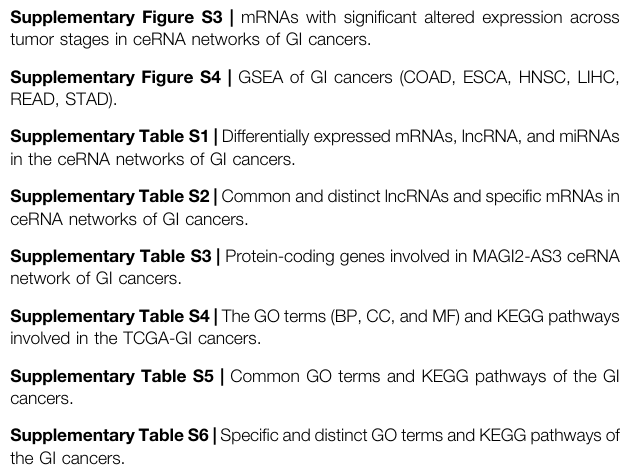
Supplementary Figure S2 | OS analysis of protein-coding genes in patients with TCGA-GI cancers (HNSC, LIHC, READ, STAD, COAD). Supplementary Figure S3 | mRNAs with signi fi cant altered expression across tumor stages in ceRNA networks of GI cancers. Supplementary Figure S4 | GSEA of GI cancers (COAD, ESCA, HNSC, LIHC, READ, STAD). Supplementary Table S1 | Differentially expressed mRNAs, lncRNA, and miRNAs in the ceRNA networks of GI cancers.